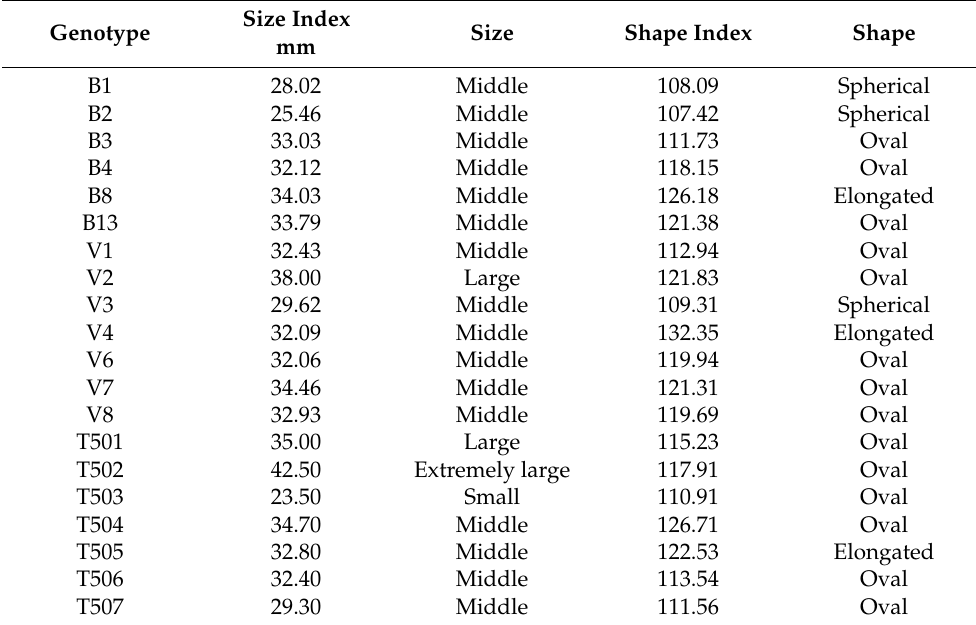
Table 3. Size and shape index of walnut of different genotype from west and north-west of